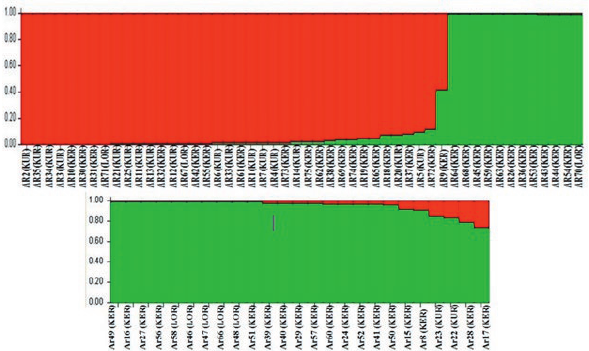
Figure 2. Membership coefficients estimated for Ascochyta rabiei isolates, determined from the greatest a posteriori likelihood using analysis with STRUCTURE and based on SSR and ISSR markers. The different isolates are represented by individual vertical bars divided into two colored segments (red and green) corresponding to the fraction of membership determined in Populations 1 and 2. The isolates are classified by province; Kermanshah (KER), Kurdis- tan (KUR) or Lorestan